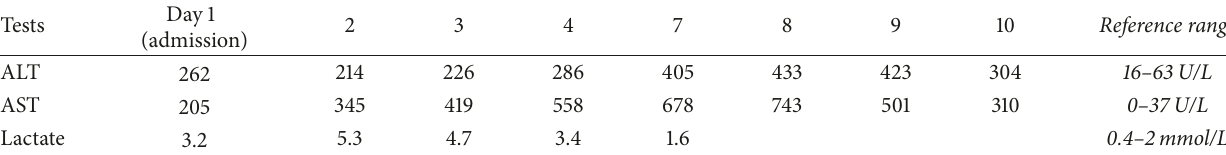
Table 1: Liver enzymes and lactic acid